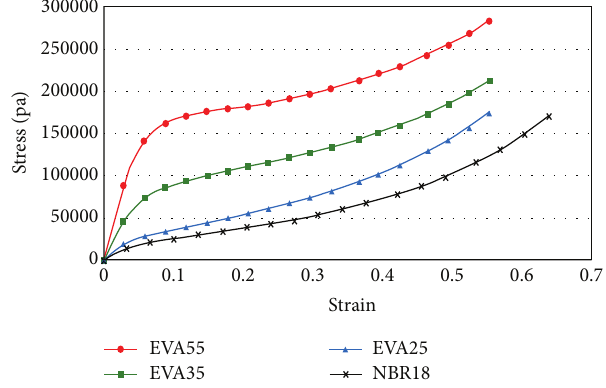
Figure 5: Stress-strain curves of resilient materials.